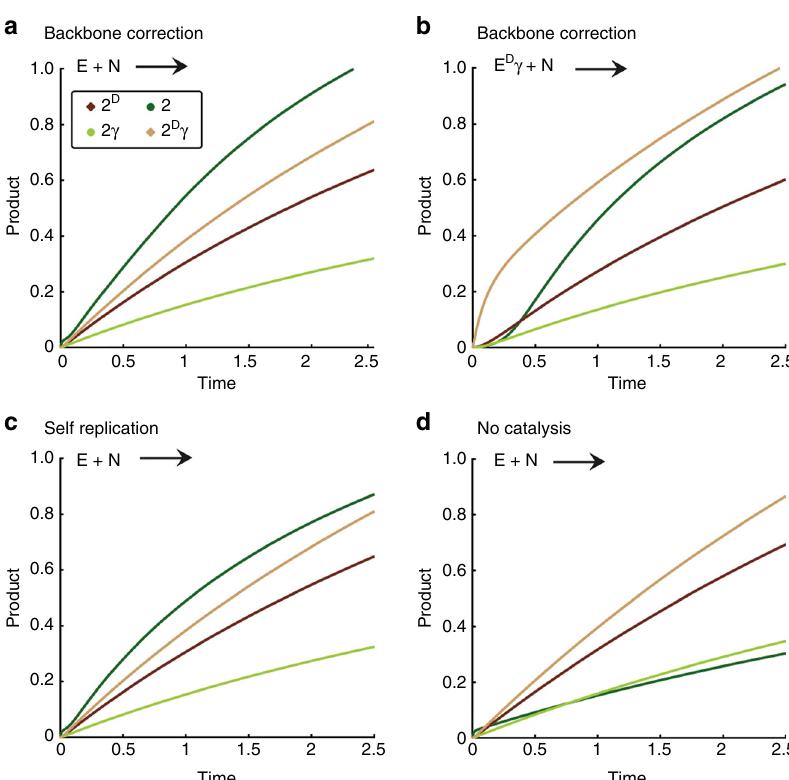
Fig. 8 Simulation results based on the mechanism shown in Fig. 5 and the reaction model given in Supplementary Fig. 13. Experimental initial concentrations were assigned for Ex and N (250 μ M each), and reaction constants were applied as speci fi ed in the SI. a , b Backbone correction growth mechanism observed when the reactions were initialized with E ( a ) or E D γ ( b ). c , d Alternate growth behavior observed when the network kinetics were governed by different sets of interactions, e.g., with more dominant self-replication c , or with no templated assisted processes